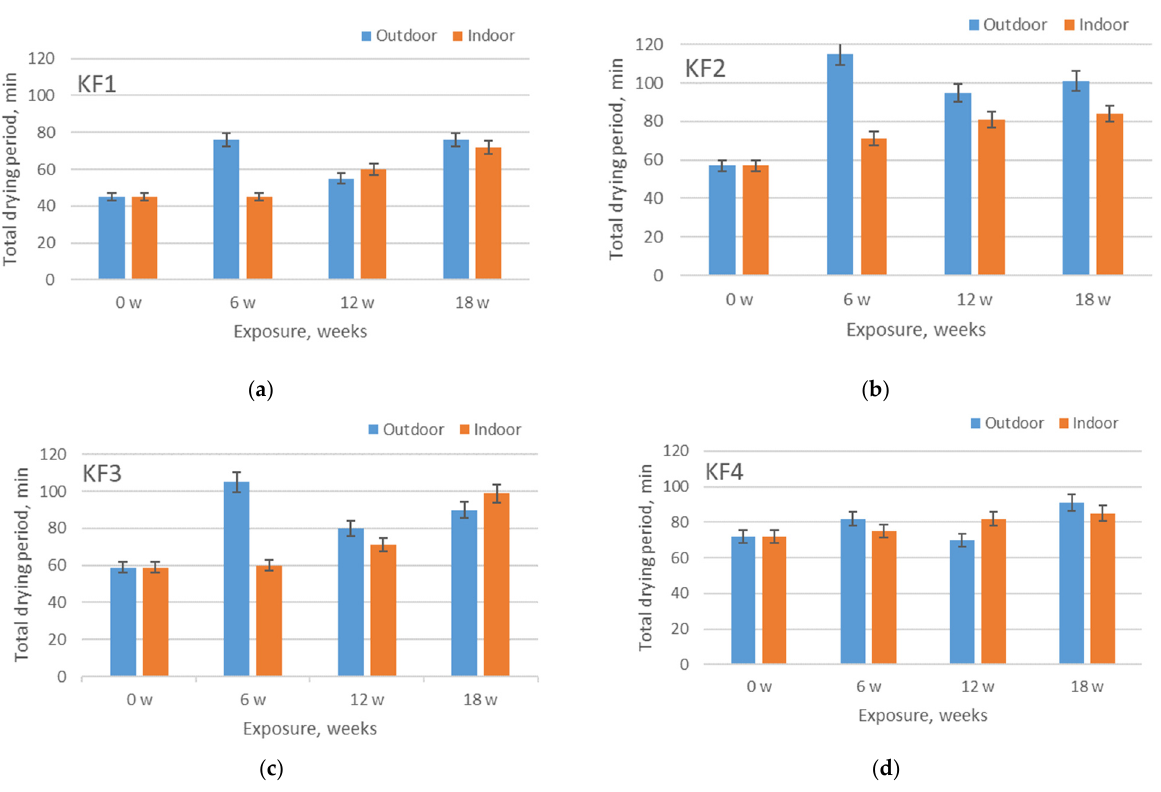
Figure 12. Comparison of total drying rate of materials exposed to aging outdoors and indoors: ( a ) material KF1; ( b ) material KF2; ( c ) material KF3; ( d ) material KF4.